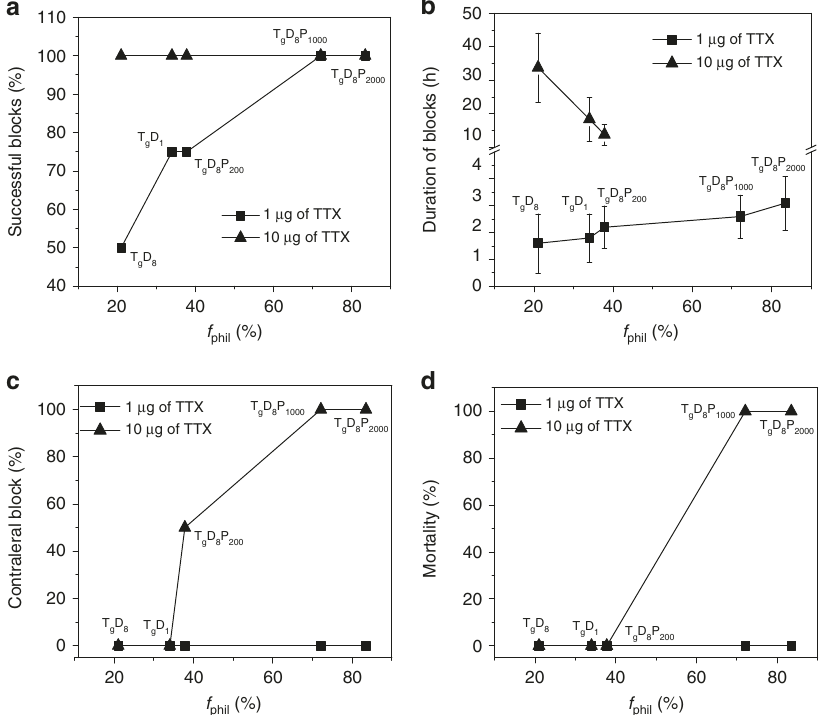
Fig. 6 Effects of f phil (%) on ef fi cacy and toxicity of sciatic nerve block. a Frequency of successful blocks, b duration of sensory nerve blocks, c frequency of nerve blocks in the uninjected (contralateral) extremity, and d animal mortality. Animals were injected with 1 or 10 µ g of conjugated TTX in TD – TTX/PEG200 or TDP – TTX/PEG200. Data are means± SD, n = 4